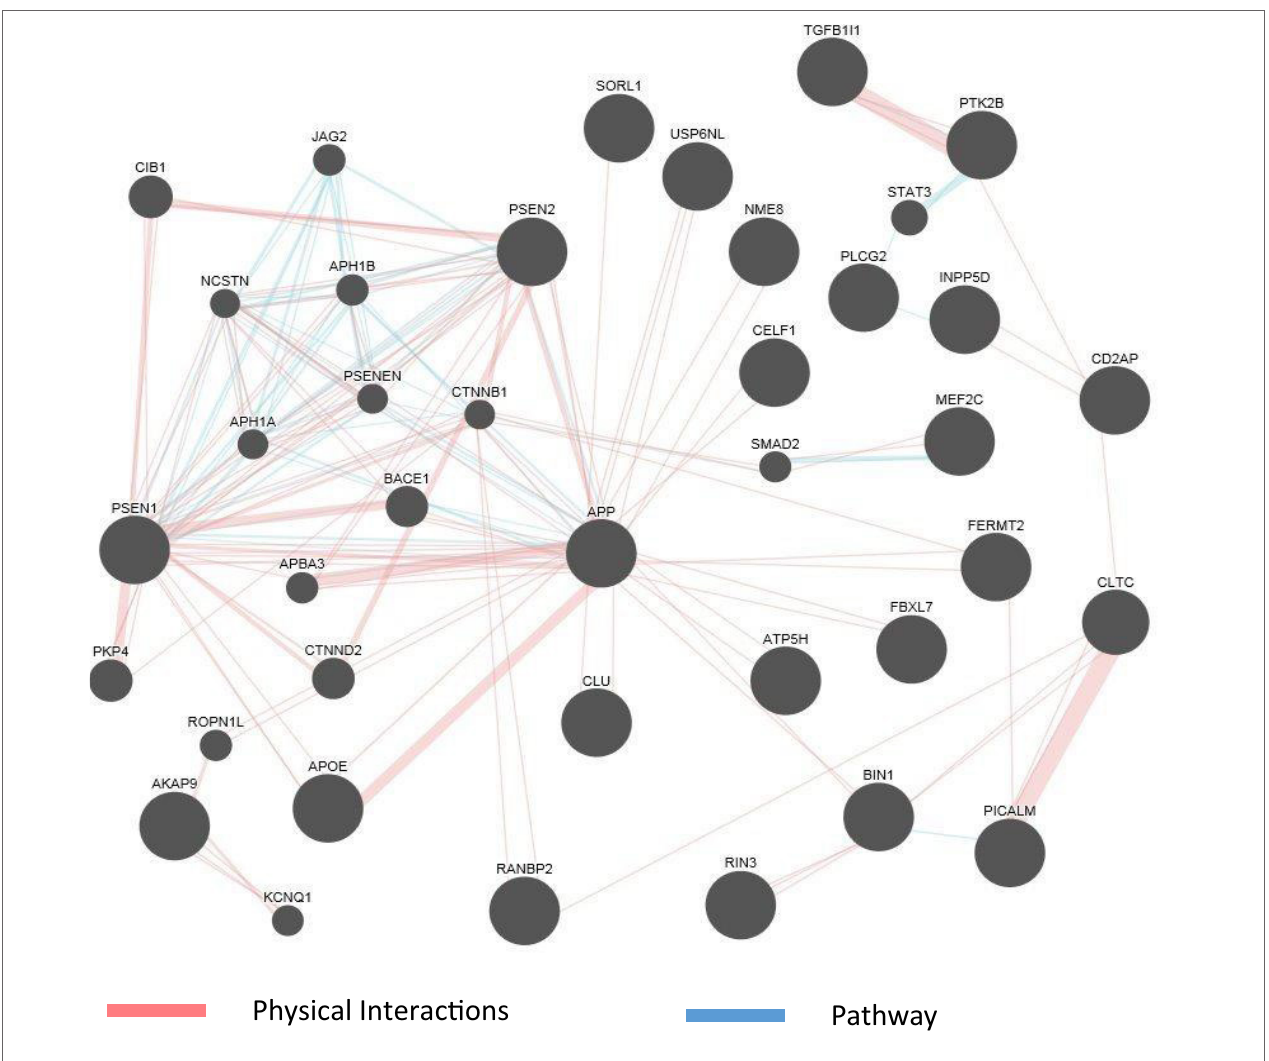
FiGURe 2 | GeneMania network for physical interaction (PI) and pathway. An example of GeneMANIA network when only the PI and pathway links are used. Alzheimer’s disease genes from input list are presented as large black circles, and other genes deemed to be associated with the cluster are small black circles. Genes not linked to the main cluster are